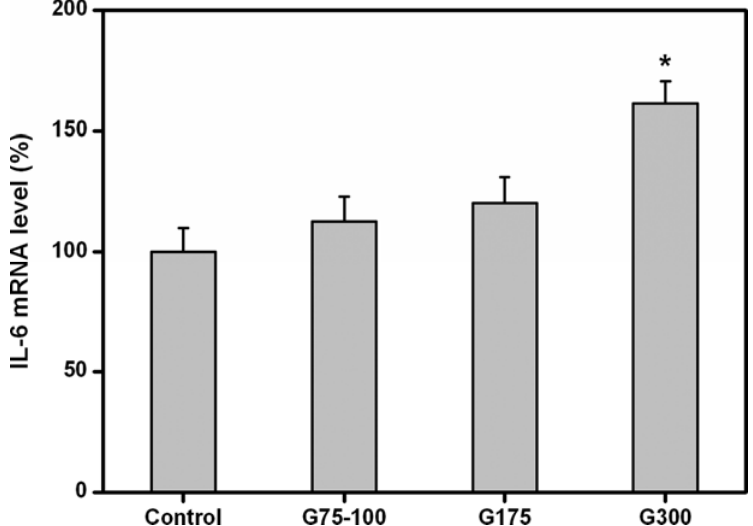
Figure 6. Gene expression of IL-6 in ARPE-19 cells incubated with various dissolved gelatin materials for two days by real-time RT-PCR.